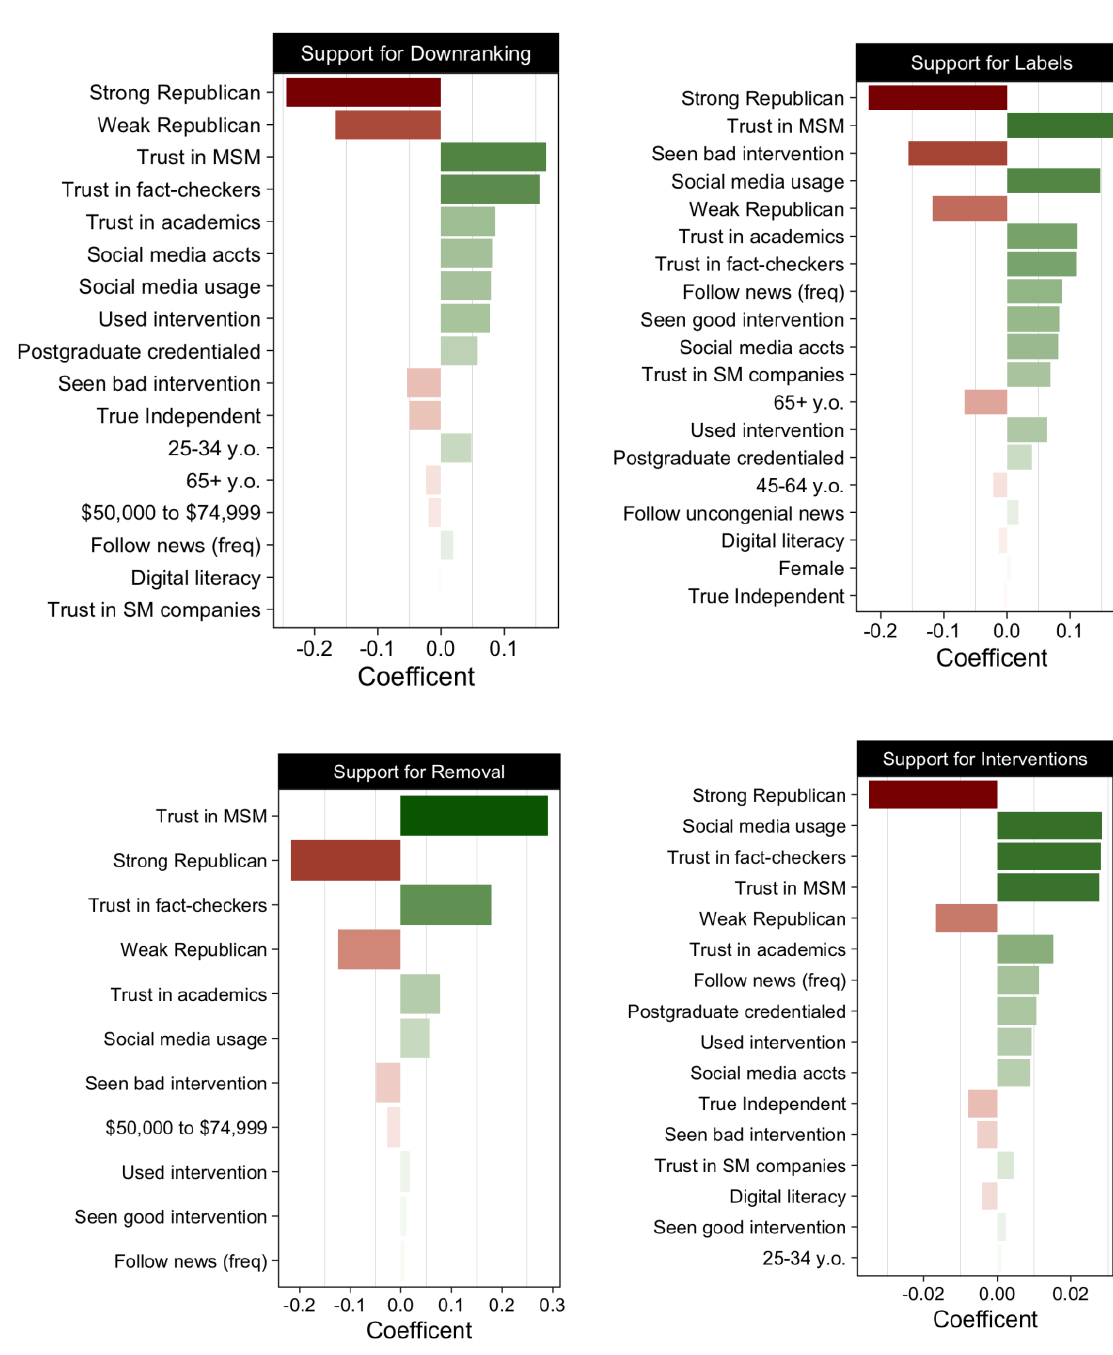
Figure 10. Top non-zero predictors of intervention support in elastic net